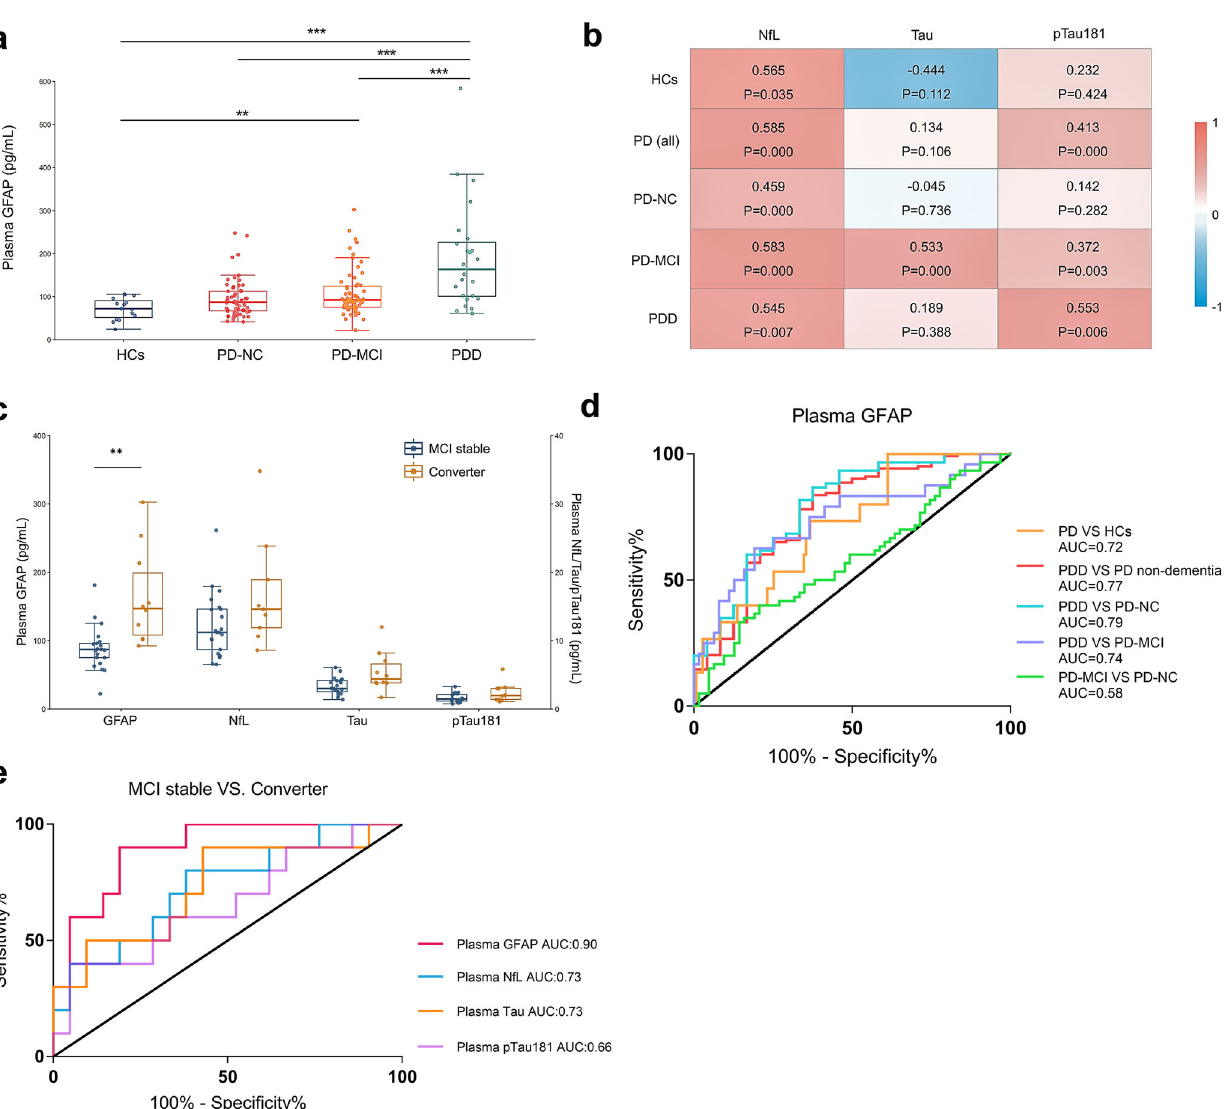
Fig. 1 Diagnostic and prognostic performance of plasma GFAP. a Plasma GFAP levels in healthy controls ( n = 15) and patients with PD-NC ( n = 60), PD-MCI ( n = 63) and PDD ( n = 24). Groups were compared by a generalized linear model after adjusting for age. Boxes show the median and IQR, and whiskers are the minimum and maximum. Dots are single values. b Correlation analysis of plasma GFAP with plasma NfL, Tau and pTau181 using Spearman ’ s partial correlation including age as a covariate. The correlation coef fi cient r is given in the heat map. c Baseline levels of plasma GFAP, NfL, Tau and pTau181 in PD patients with MCI stable ( n = 21) and conversion to dementia (converter, n = 10) during the whole follow-up period. Groups were compared by the Mann – Whitney U test. Boxes show the median and IQR, and whiskers are the minimum and maximum. Dots are single values. d Receiver operating characteristic (ROC) curve analysis indexed the ef fi ciency of plasma GFAP for the differential diagnosis of Parkinson ’ s disease subgroups strati fi ed according to cognitive status. e ROC curve analysis for baseline levels of plasma GFAP, NfL, Tau, and pTau181 to predict MCI-to-dementia conversion during the next 4.1 ± 2.3 years. * p < 0.05, ** p < 0.01, *** p < 0.001. HCs healthy controls, PD-NC Parkinson ’ s disease with normal cognition, PD-MCI Parkinson ’ s disease with mild cognitive impairment, PDD Parkinson ’ s disease dementia, AUC area under the